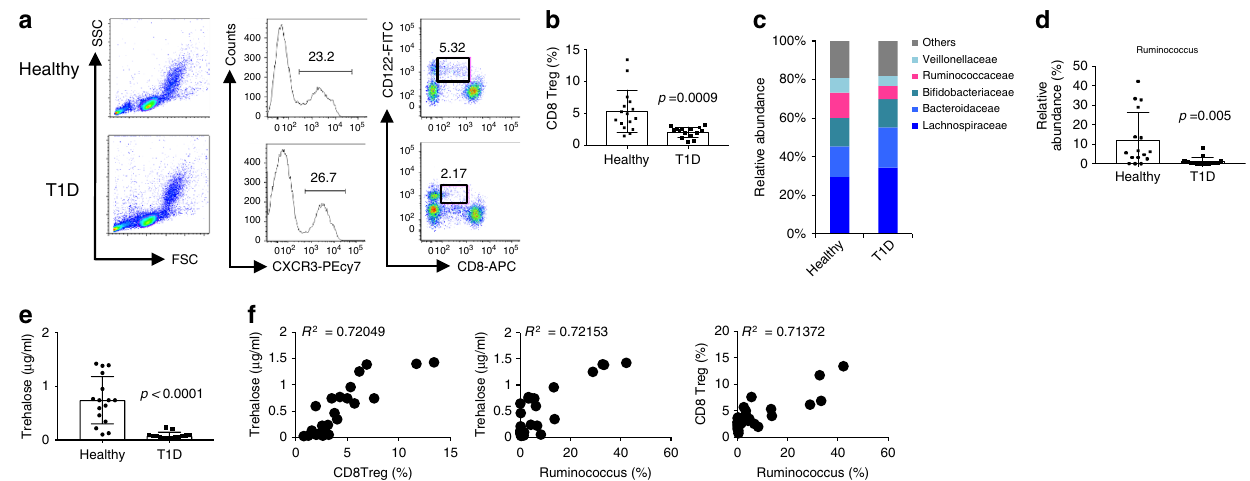
Fig. 4 Patients with T1D have fewer CD8 + Treg cells compared with healthy volunteers. Evaluation of CD8 + Treg cells and microbiota in T1D patients ( N = 15) and healthy volunteers ( N = 16) was performed. a Peripheral blood mononuclear cells obtained from T1D patients were stained with fl uorescent dye-labelled anti-CD8, anti-CXCR3, and anti-CD122 antibodies. CXCR3 + cells among gated lymphoid cells ( left and centre panels ) were separated into CD8 + and CD122 + ( right panels ). The numbers indicate the percentages of gated cells. b Frequency of CD8 + Treg cells de fi ned as CXCR3 + CD8 dull CD122 + cells in T1D patients and healthy volunteers is plotted as a scatter graph with bars. c Composition of the intestinal microbiota in T1D patients and healthy volunteers at the family level. d Frequency of genus Ruminococcus in whole intestinal bacteria. e Trehalose concentration in serum from T1D patients and healthy volunteers. Values represent the mean ± SD. f Representative co-plotted frequency of CD8 + Treg cells, abundance of Ruminococcus , and trehalose concentration in T1D patients and healthy volunteers. R 2 denotes the correlation coef fi cient. p -values were calculated using the two-tailed Mann – Whitney test ( b , d , e ). All experiments using human samples were performed